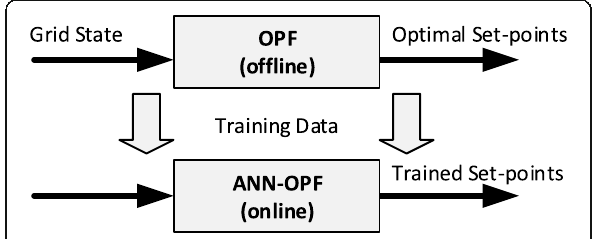
Fig. 1 (abstract PW2). Mapping of grid state to optimal set-points using offline generated training data